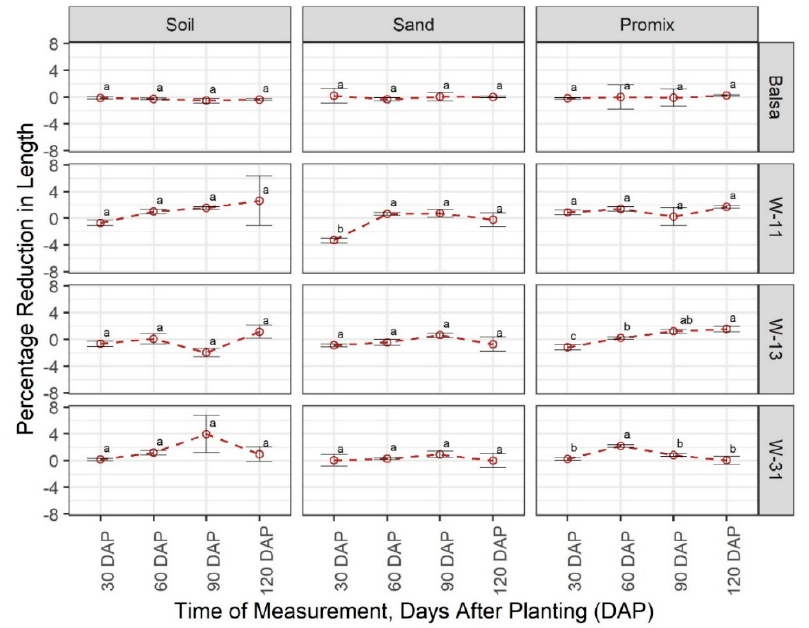
Figure 2. Comparison of percentage change in material length in three growing media (Promix, sand, and soil) at four growth stages (30, 60, 90, and 120 days after transplanting (DAP)). Different lowercase letters indicate significant differences in % length change between different growth stages, at α = 0.05, within each growing media and material, whereas same letters indicate no significant difference across compared treatments. W-11, 1:1 blend of beeswax and soy wax; W-13, 1:3 blend of beeswax and soy wax; and W-31, 3:1 blend of beeswax and soy wax.